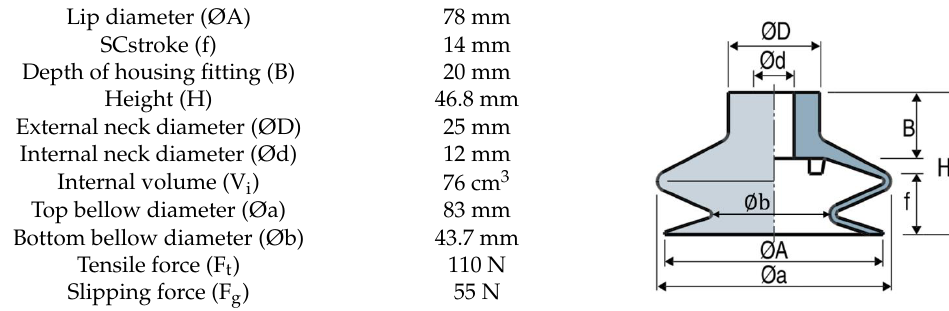
Table 1. Dimension and force characteristics of a Ø78 suction cup.